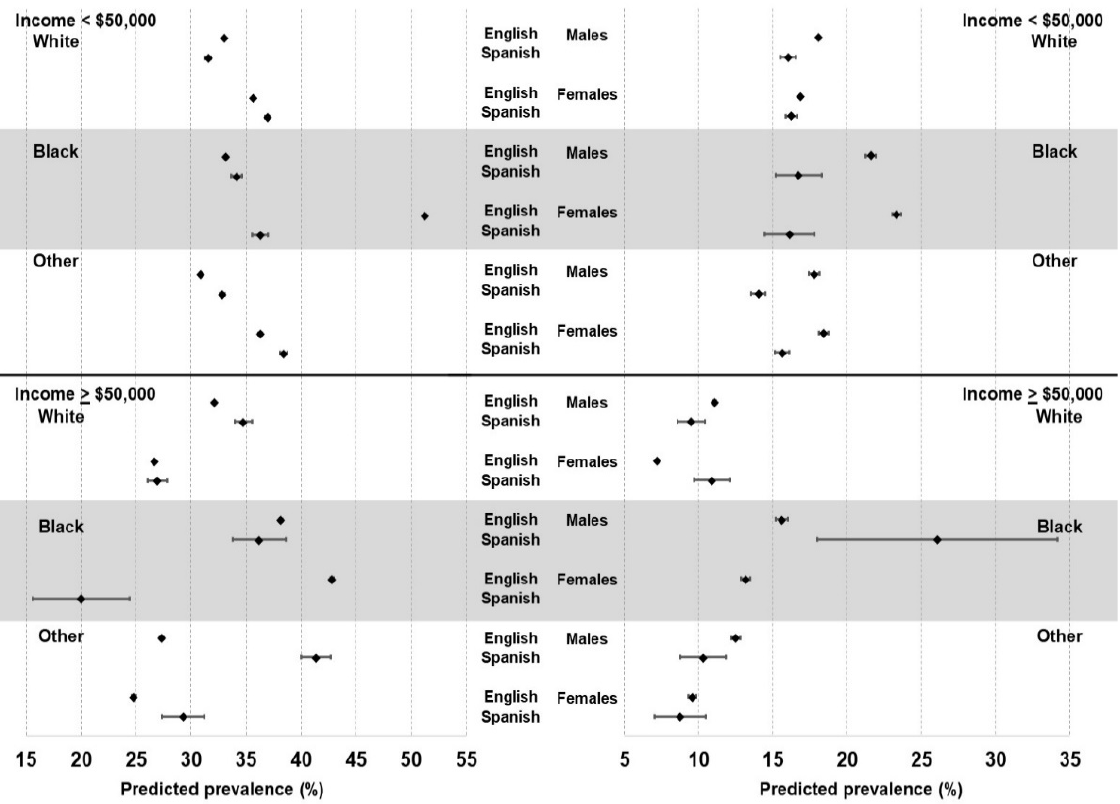
Figure 1. Predicted prevalence (and 95% confidence intervals) of obesity ( left ) and diabetes ( right ) by gender, race/ethnicity, income, and preferred language spoken.